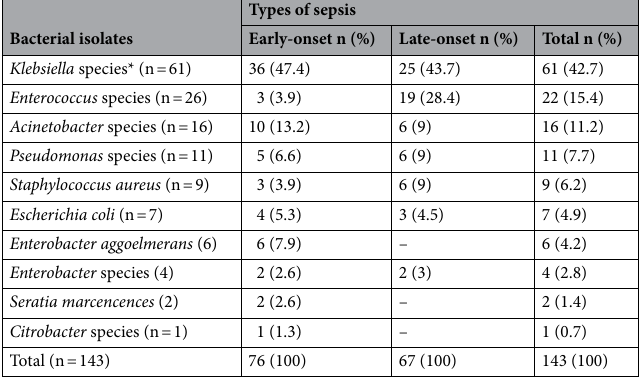
Table 3. Distribution of bacteria across early-onset and late-onset sepsis at neonatal intensive care unit of Hawassa University Comprehensive Specialized Hospital, Hawassa, Ethiopia, March 2021–November 2021 (N = 143). * Klebsiella pneumoniae = 46, Klebsiella ozenae = 13, Klebsiella oxytoca =